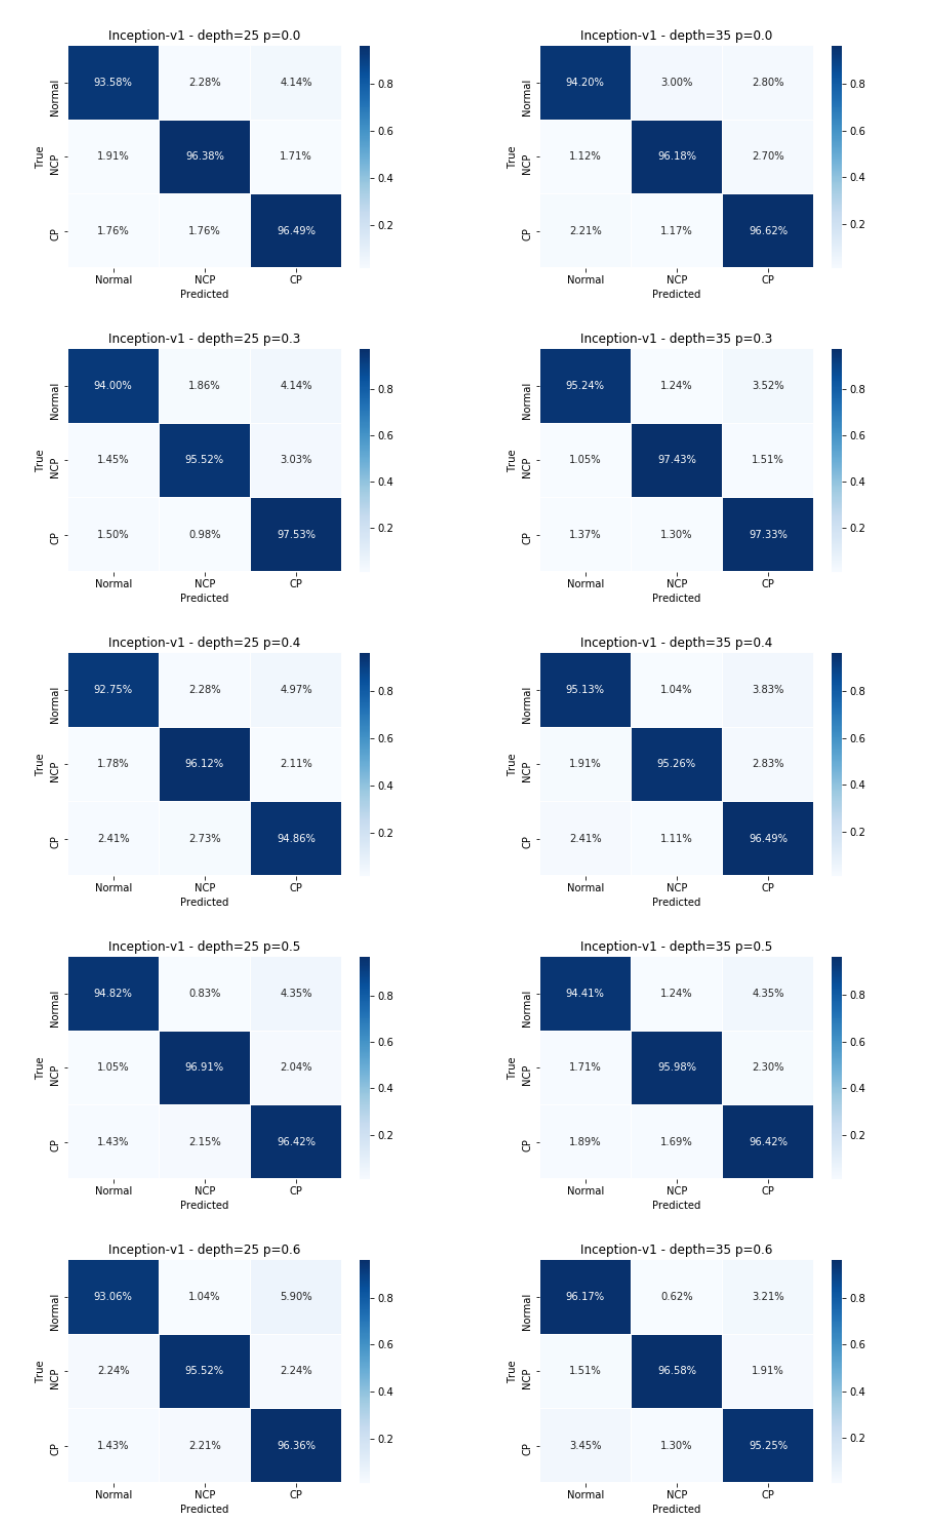
Figure 11. Inception-V1 individual models—The normalized matrices for the individual models built varying the dropout rate p using a CT scan depth of 25 and 35